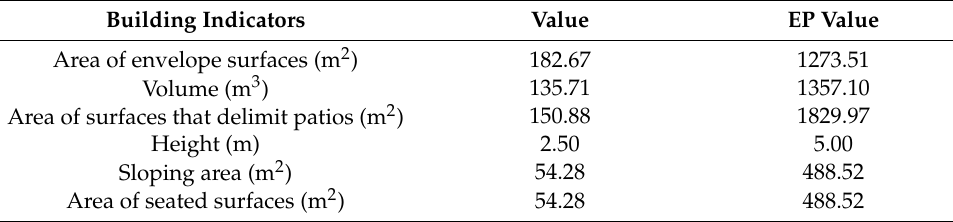
Table 4. Main differences between the indicators of buildings EC and RC.